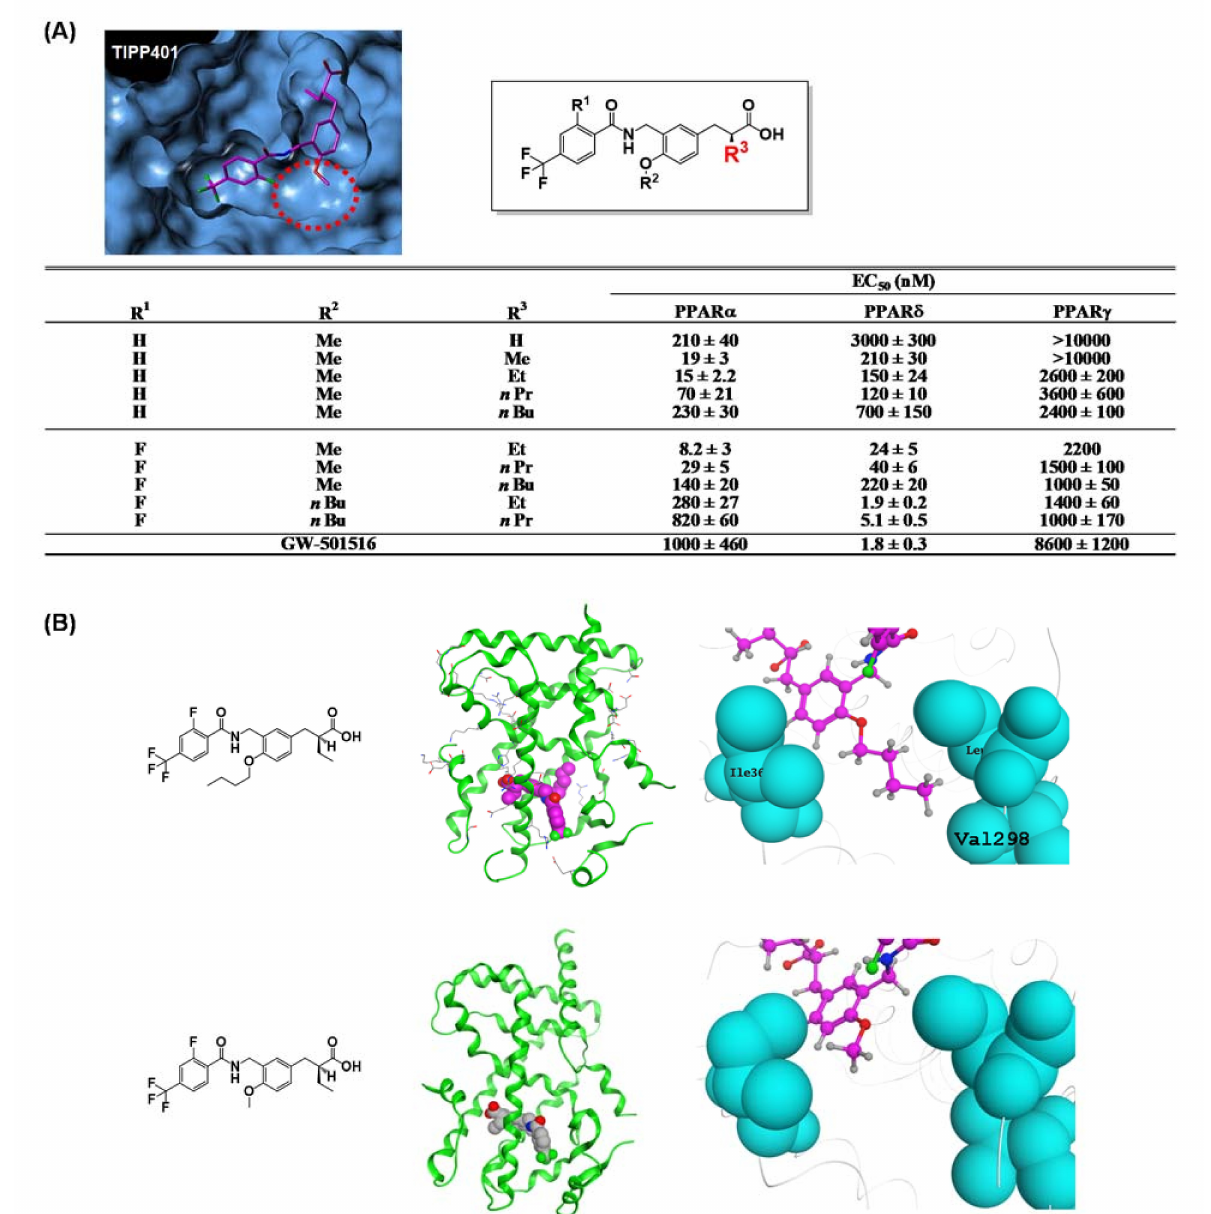
Figure 9. ( A ) Molecular modeling structure of TIPP-401 bound to the PPAR δ LBD. The binding pocket surrounding the alkoxy side chain is indicated with a red dotted circle. Transactivation activity of a series of compounds is listed in the table. ( B ) (left) Overall crystal structure of TIPP-401 and TIPP-204 complexed with the PPAR δ LBD. (right) Zoomed view of the alkoxy side chain of TIPP-401 and